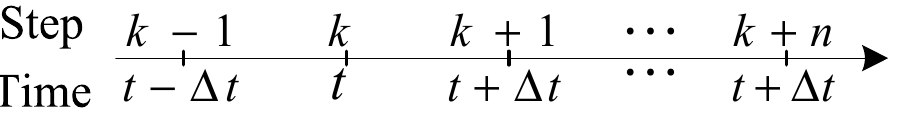
Figure 6. Time series of tracking process.